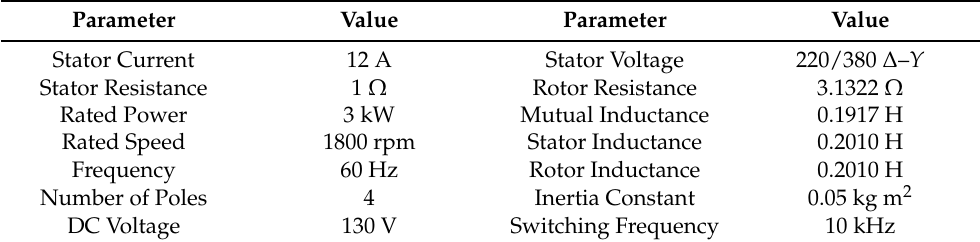
Table 2. Parameters of the DFIG and the experimental